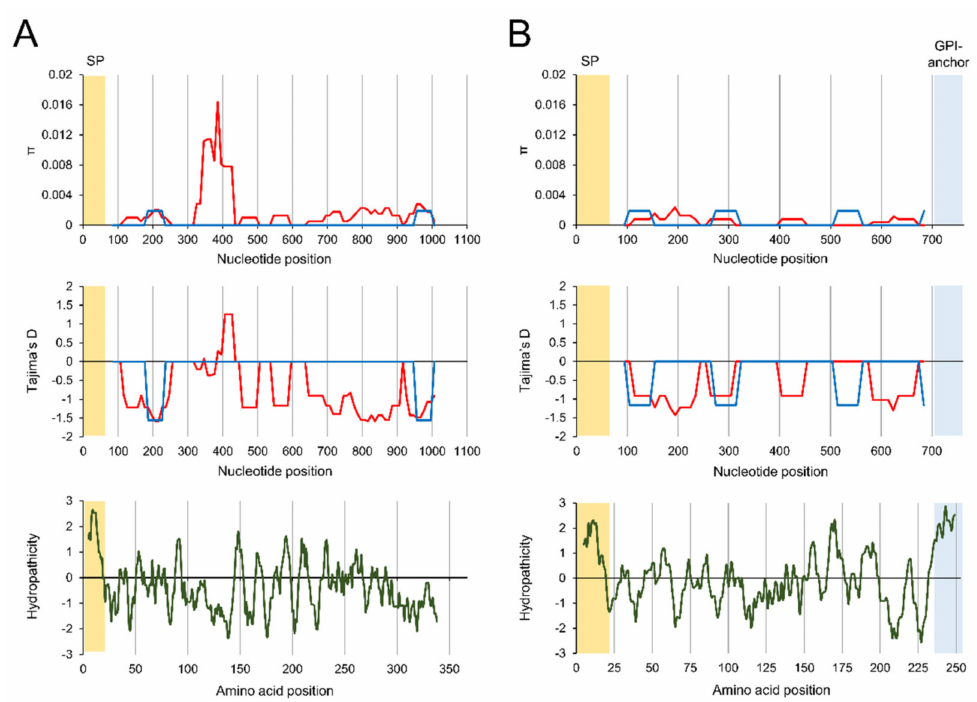
Figure 4. Nucleotide diversity and natural selection of etmic2 and etsag1 : ( A ) etmic2 ; ( B ) etsag1 . Sliding window plot analyses for nucleotide diversity ( π ) and Tajima’s D across etmic2 and etsag1 were performed. The window size of 50 bp and a step size of 10 bp were used. Red lines, Korean etmic2 and etsag1 ; blue lines, Chinese etmic2 and etsag1 . Hydropathy analysis for each protein was also performed. SP: signal